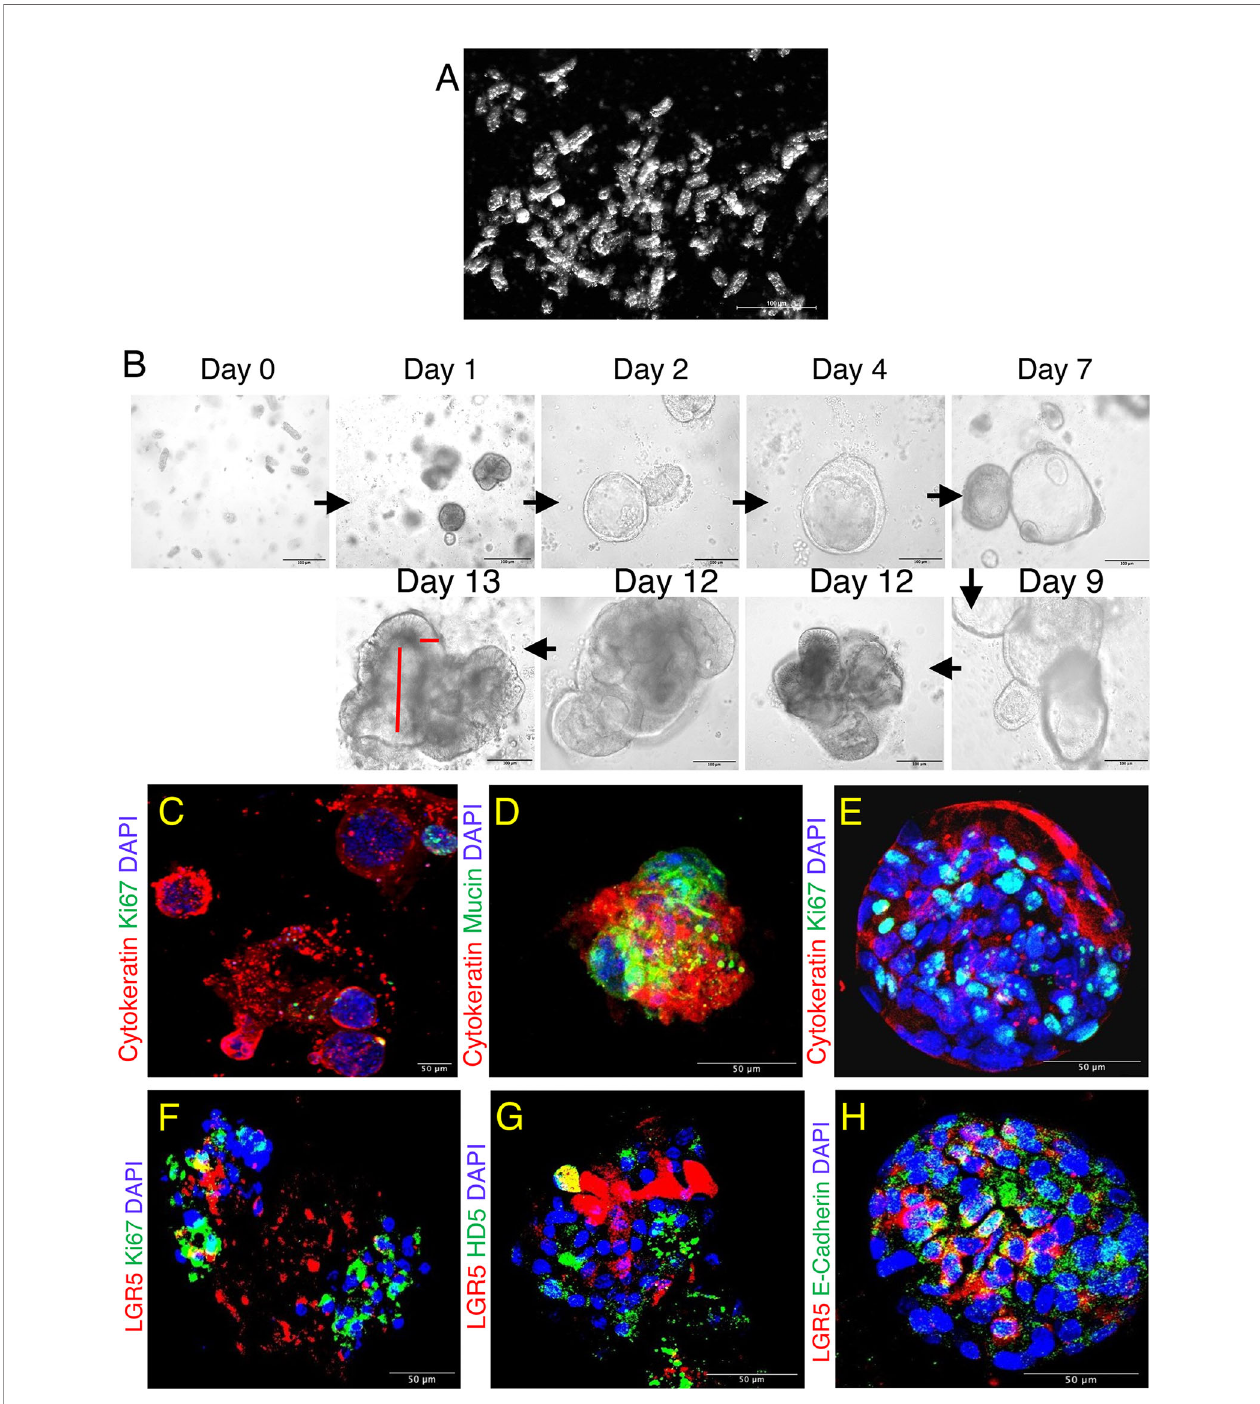
FIGURE 2 | Jejunum enteroids and its phenotypic characterization in normal SIV infected rhesus macaque. (A) Isolated short tubular shaped glandular crypts show the purity of the crypt suspension detected by dark fi eld microscopy. (B) Typical images of enteroids grown from single jejunum crypt. Lumen-like cystic structures started to form on days 2-4, budding events started on days 2-7, and maximum budding occurred at day 9 and was maintained onwards. The longitudinal and vertical red lines shown for day 13 represent enteroid lumen and epithelial cell lining, respectively. (C) Confocal images of enteroids showing the presence of epithelial cells (cytokeratin+) and proliferating (Ki67+) cells. Note that the proliferating cells were present at the tip of the budding structure. (D – F) Confocal images of subcultured enteroids showing goblet cells (mucin+, D ) and proliferating cells (Ki67+, E, F ) along with LGR5+ and epithelial markers after 7 days of culture. (G, H) First subculture of enteroids also shows expression of HD5 (Paneth cells+, G ), and cell adhesion molecule (E-cadherin+, H ) along with continued presence of LGR5+ stem cells after 7 days of culture. DAPI represents nuclear